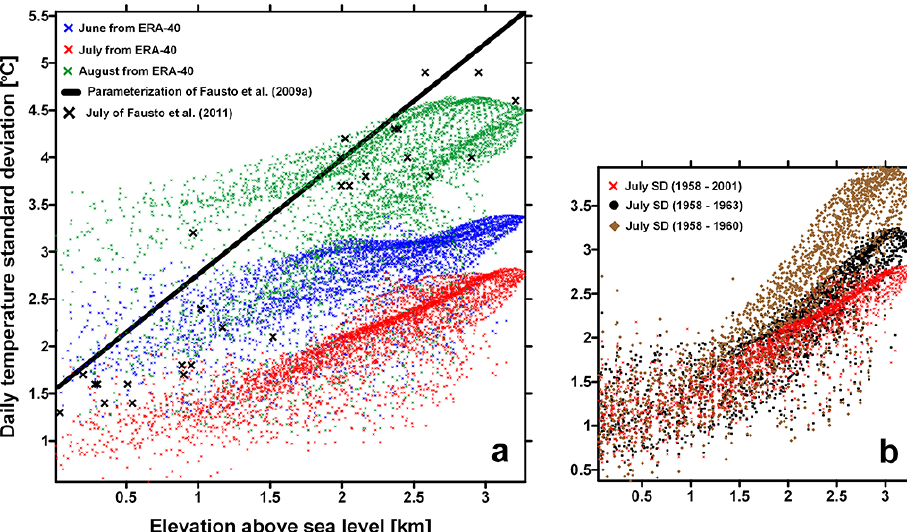
Fig. 3. SD values versus surface elevation above sea level. (a) Scatter plots of June (blue), July (red) and August (green) SD values derived from ERA-40 temperature time series across Greenland. Thick black line depicts the relation between mean summer SD values and sur- face elevation suggested by Fausto et al. (2009a). Black crosses depict the July SD values interred from temperature measurements from 27 weather stations in Greenland (Fausto et al., 2011). (b) Sensitivity of SD values to the length of a temperature time series used: 44yr (red), 6yr (black), and 3yr